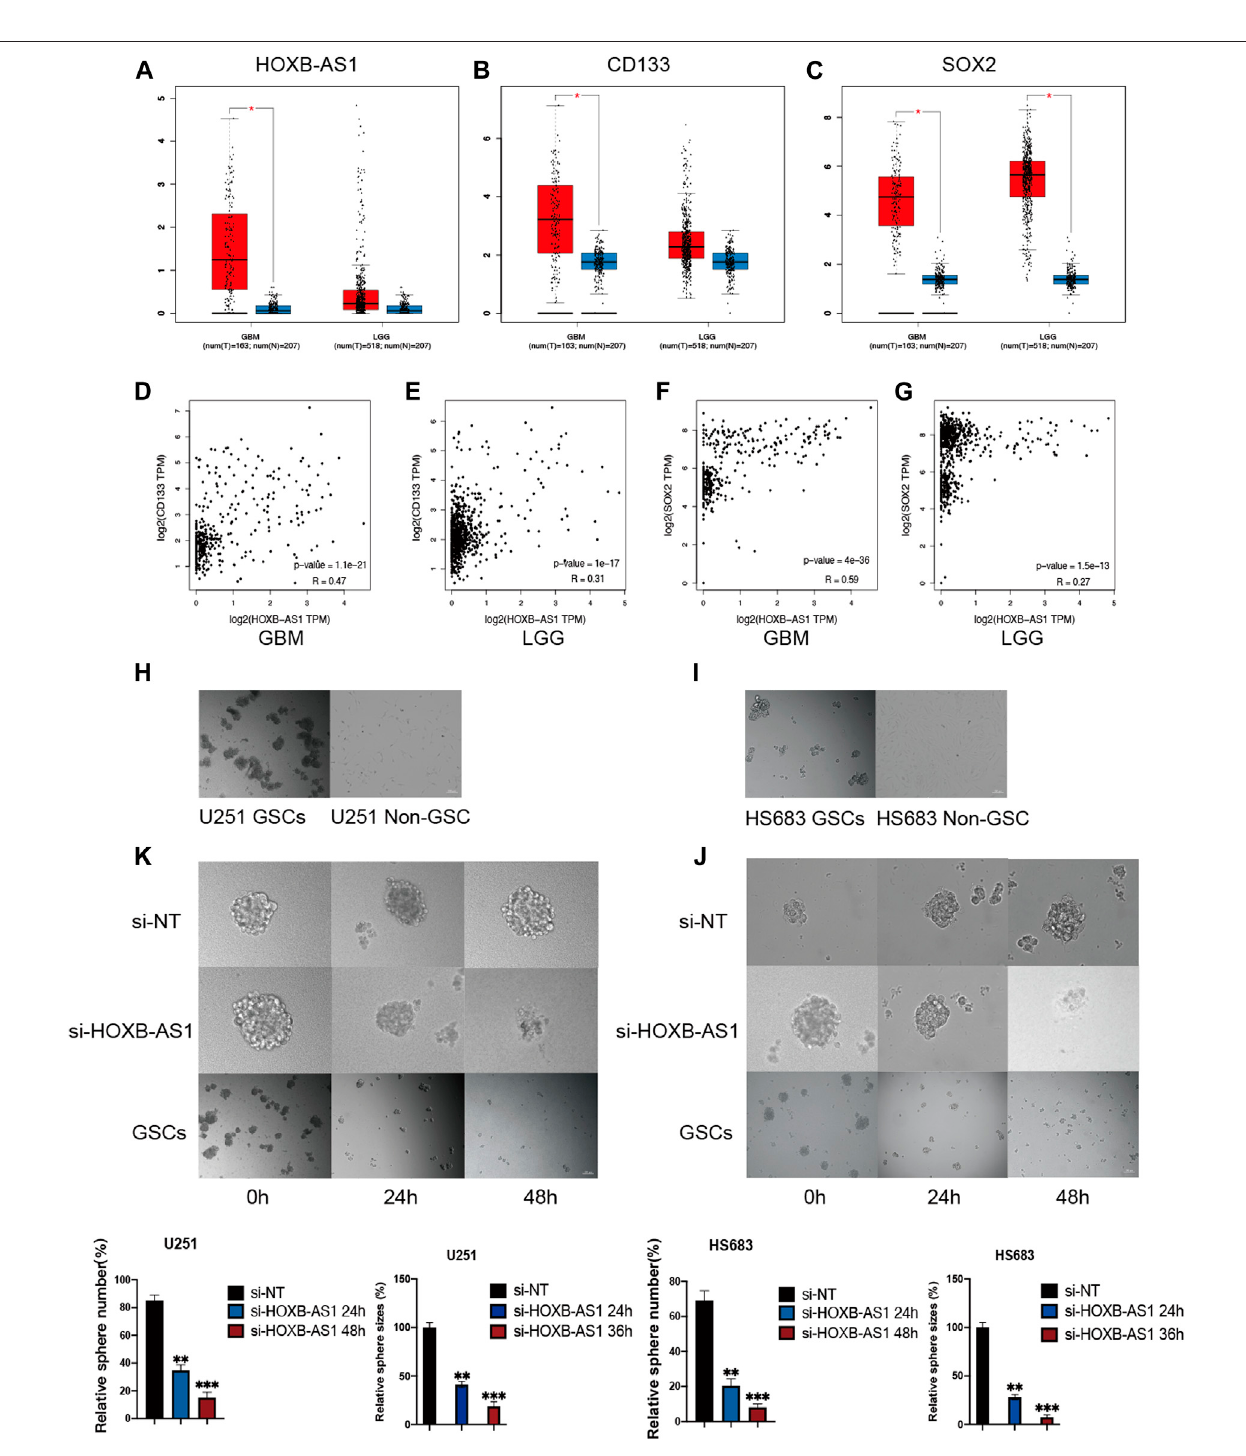
FIGURE 8 | HOXB-AS1 is Required for GSC Maintenance and Survival. Comparison of HOXB-AS1, CD133 and SOX2 expression levels between LGG and GBM data sets (A – C) . The red column represents the glioma samples, and the blue column represents the normal samples. Correlations between differentially expressed HOXB-AS1 and stemness genes in GBM and LGG patients (D – G) . The representative images of neurosphere-cultured GSCs and 2 established GSC cells (H, I) . SilencingofHOXB-AS1inhibits theproliferationand tumorigenicityofGSCs inU251andHS683.Theeffects ofsiRNA targeting ofHOXB-AS1onspheroid-forming ability in GBM and LGG cells were detected by sphere formation assay (K, J) . Bar: 100 μ m *p < 0.05, **p < 0.01, *** p < 0.001.